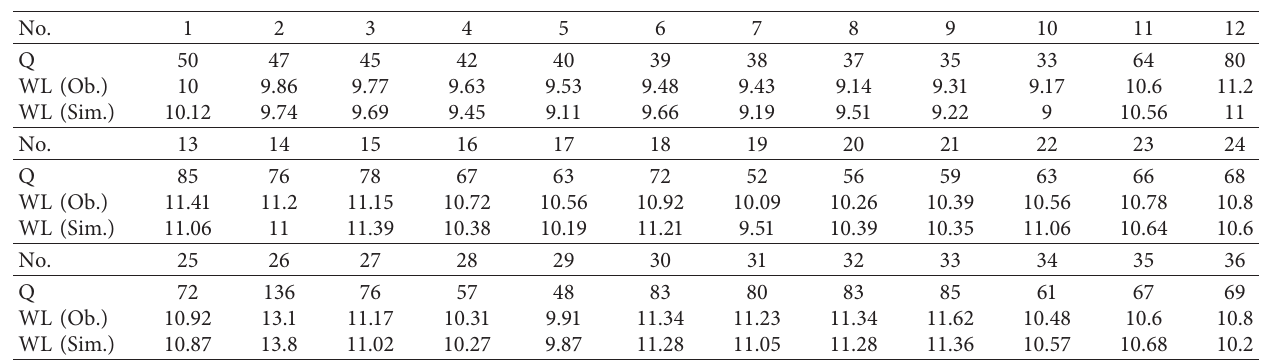
Table 3: Validation of